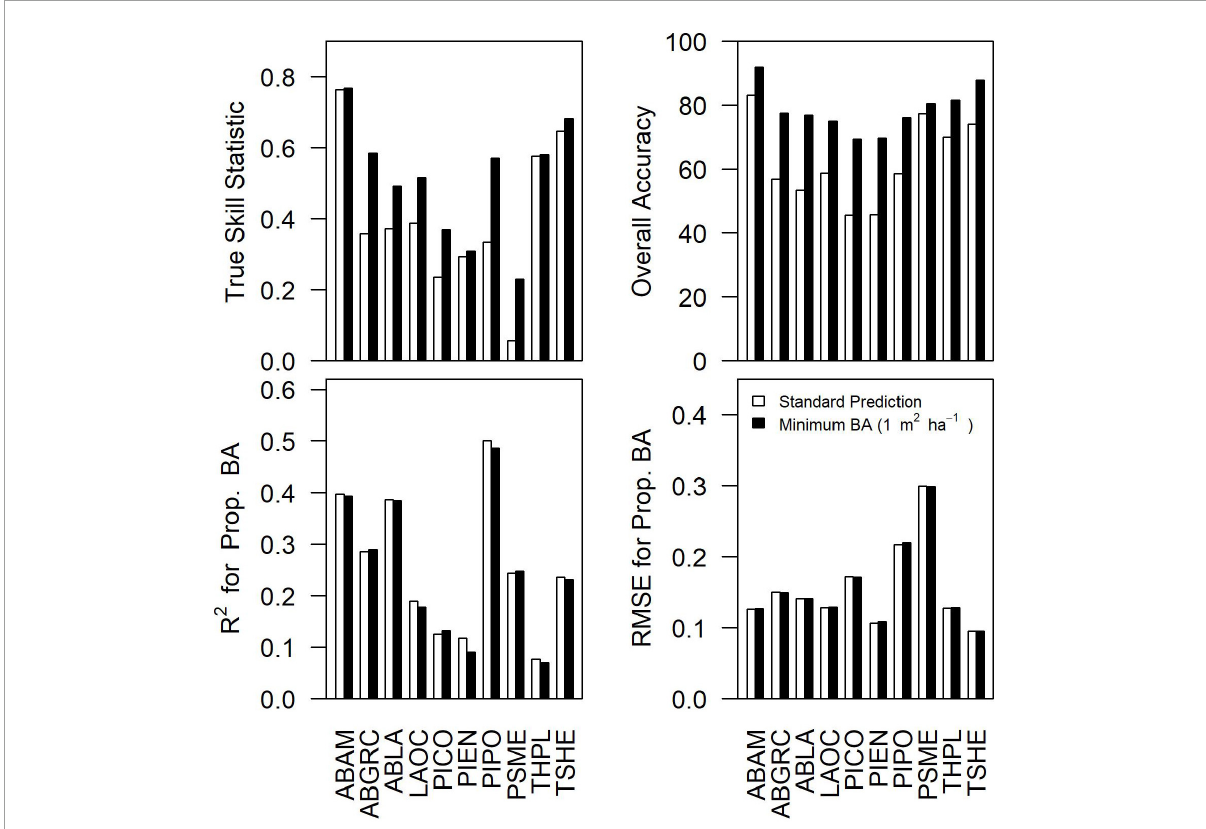
FIGURE2 Differences in true skill statistic, overall accuracy, R 2 for proportional basal area, and RMSE for the proportional basal area between the standard prediction from the consensus model and the predictions assuming species basal area less than 1 m 2 ha − 1 indicate species functional absence (i.e., BA = 0 m 2 ha − 1 ). Accuracy results based on standard GNN predictions aggregated over the 25-pixel footprint. Species abbreviations can be found in Table 1